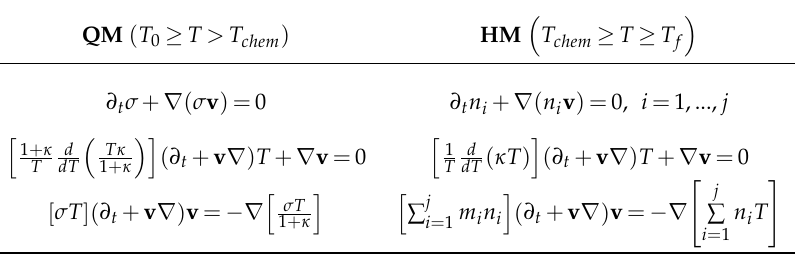
QM ( T 0 ≥ T > T chem